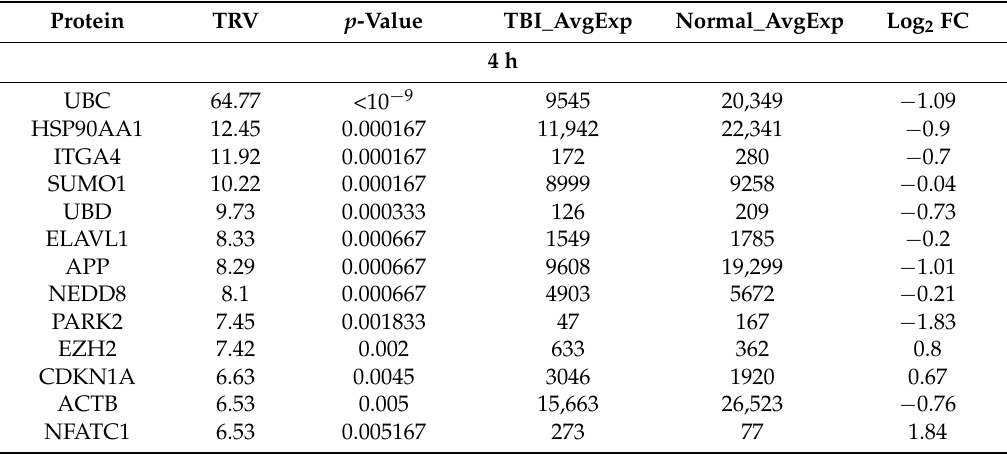
Table 1. The 20 proteins with the highest TBI relevance values (TRVs) at four time points